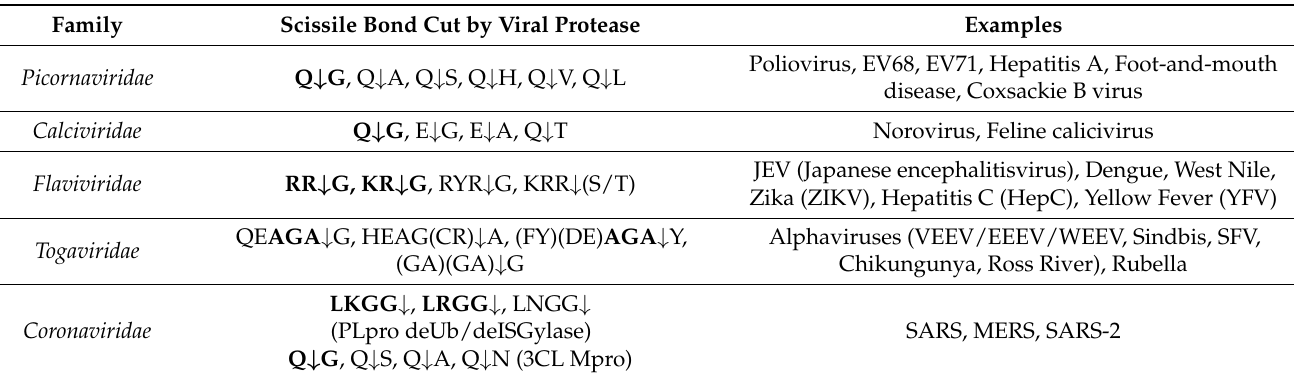
Table 1. Scissile bonds from several (+)ssRNA